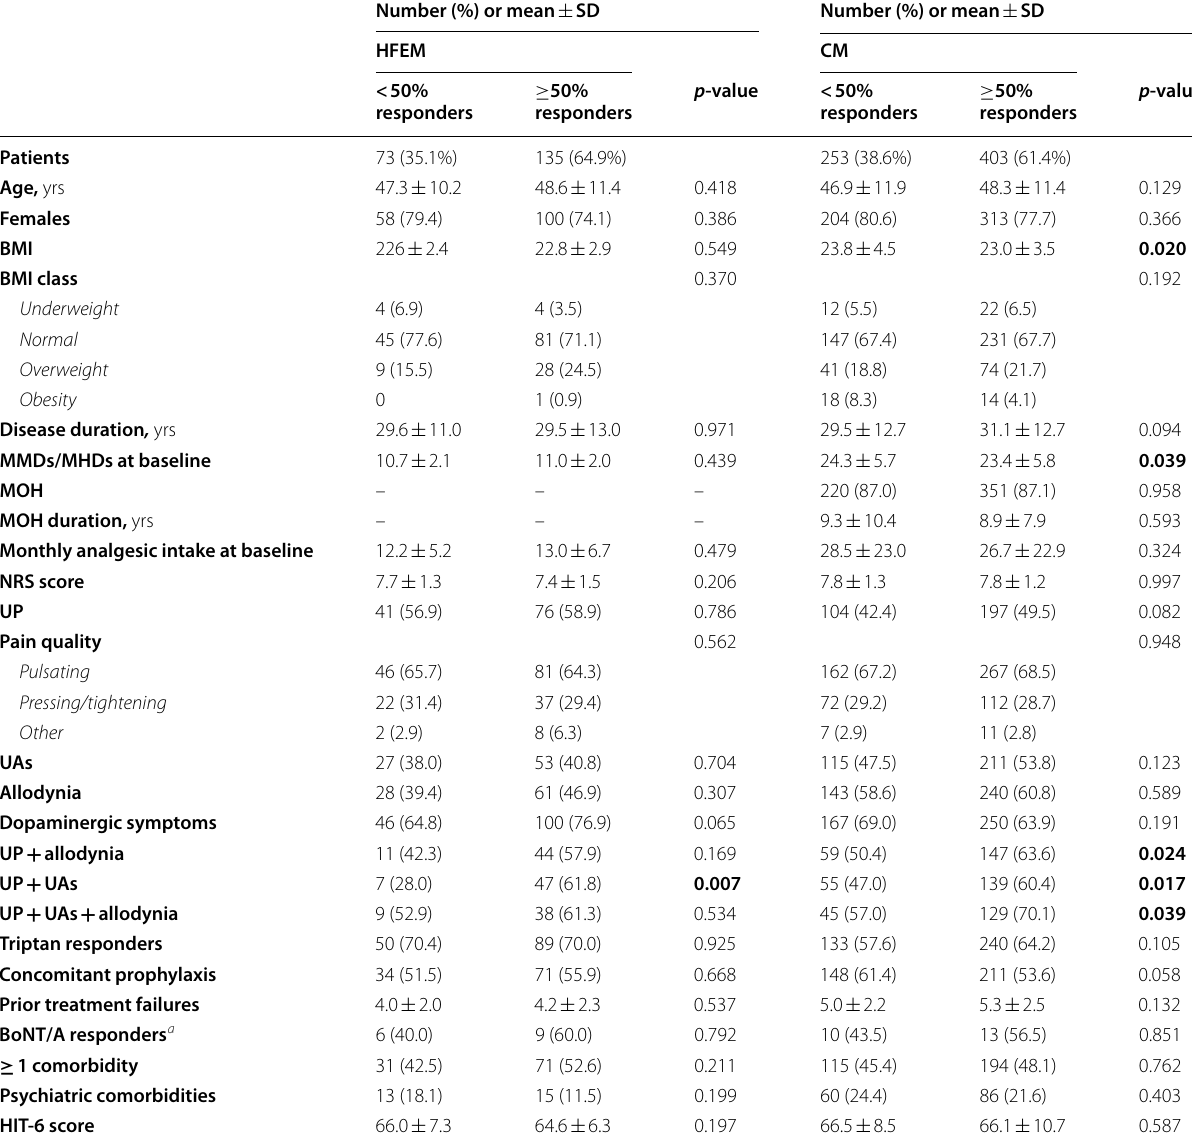
Table 2 Demographic and clinical characteristics of < 50% responders and episodic (HFEM) or chronic migraine